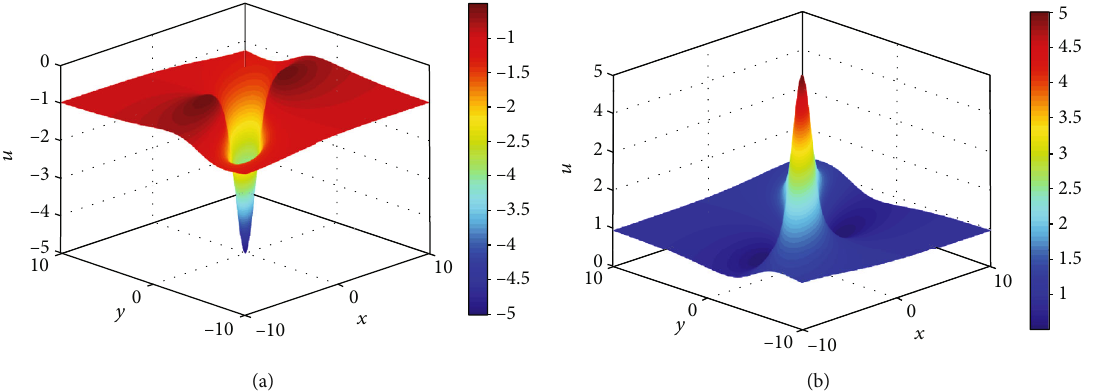
= 1 , b = − 1 , K = 1 − i , K = 1 + i , P = − 2 , and P = − 2 at t = 0 . (a) 0 1 2 1 2